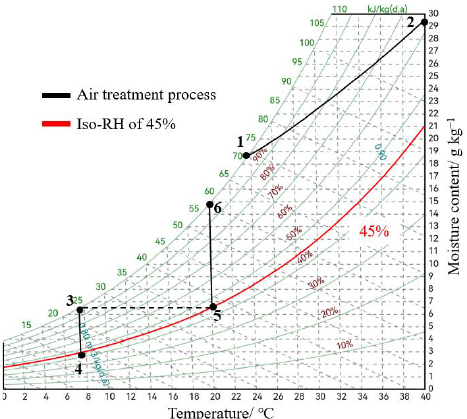
Figure 11. Limitations and adaptations of a standalone dehumidification system.